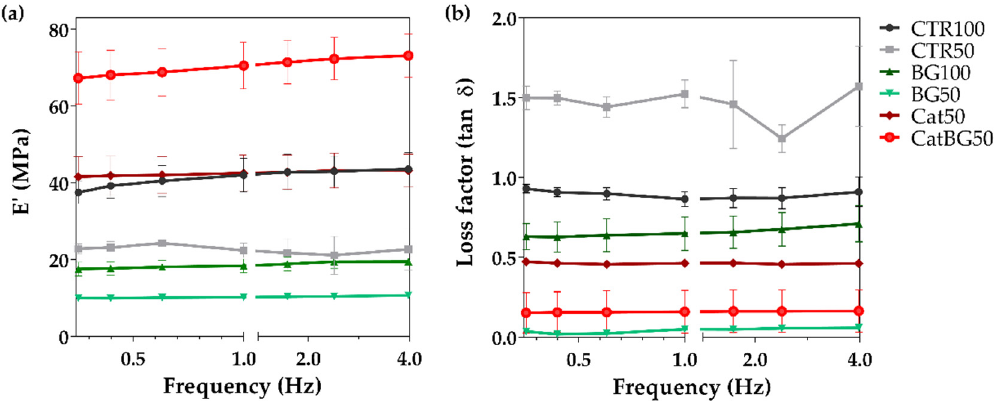
Figure 11. Dynamic mechanical analysis (DMA) measurements: Variation of the storage modulus ( a ) and loss factor ( b ) along a frequency scan ranging from 0.1 to 10 Hz at 37 °C, of the LbL films.